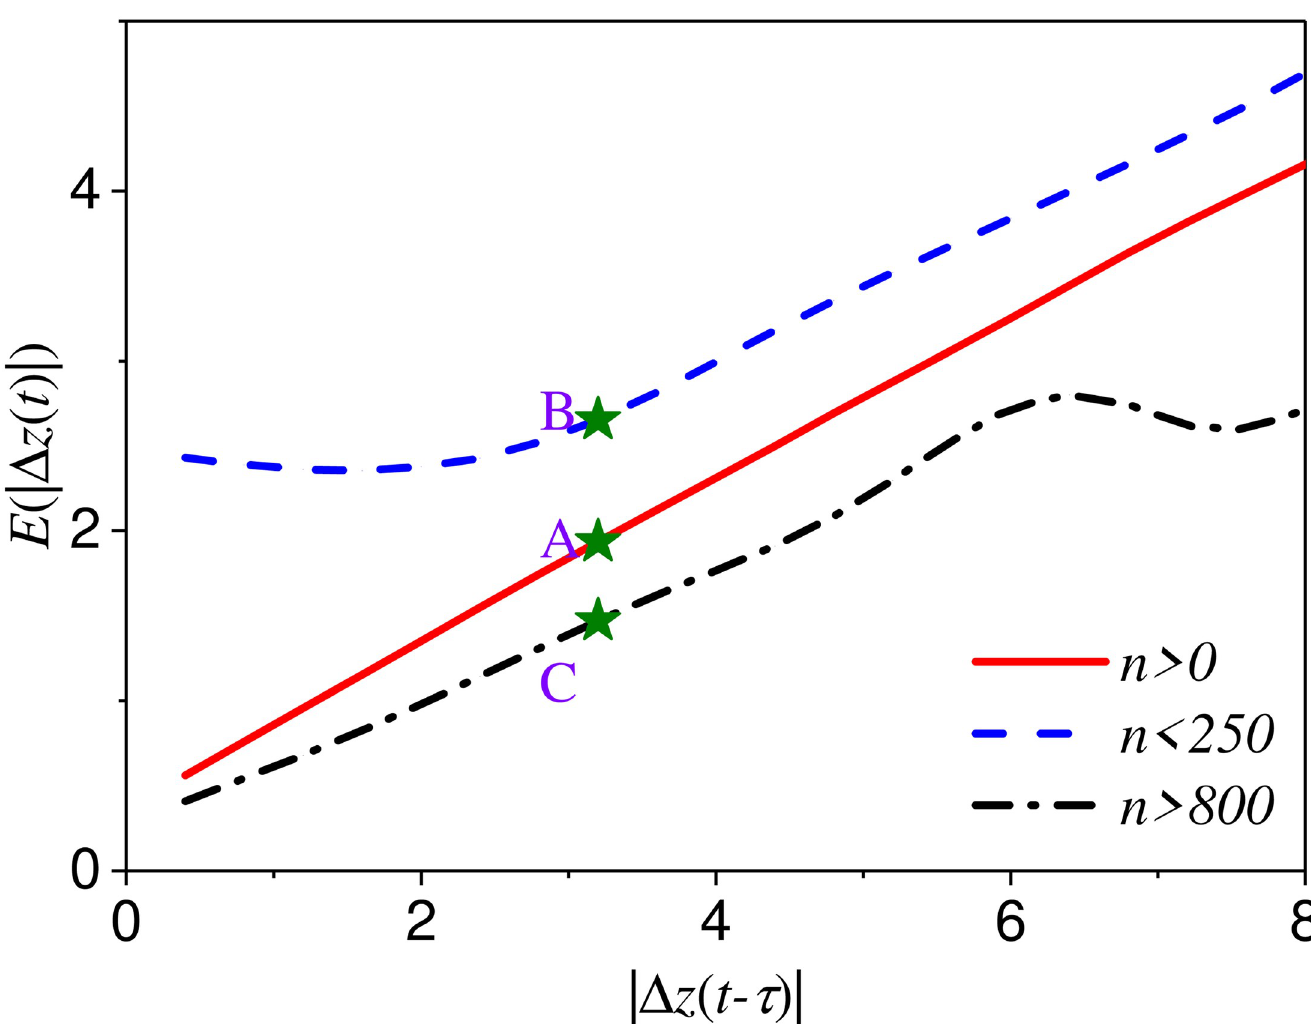
Fig 4. The relationship between the fluctuation of price in time t − τ and the fluctuation in time t for different order volumes.